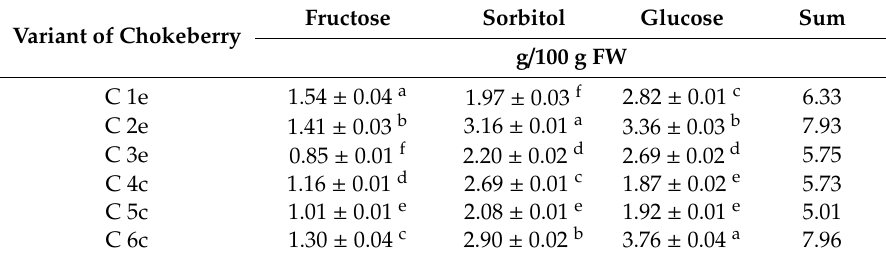
Table 3. Sugar content in black chokeberry